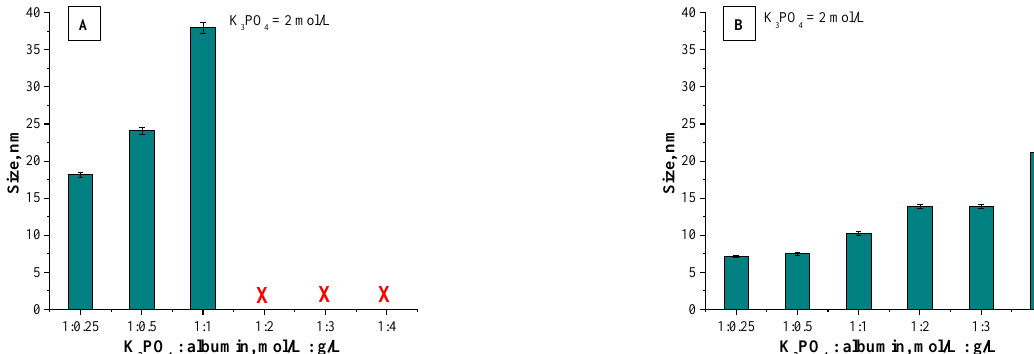
Figure 6. Results of DLS analysis of albumin particles obtained using various albumin concentrations via a syringe system ( A ) and using a burette ( B ) ( n = 3, n —Number of repetitions).